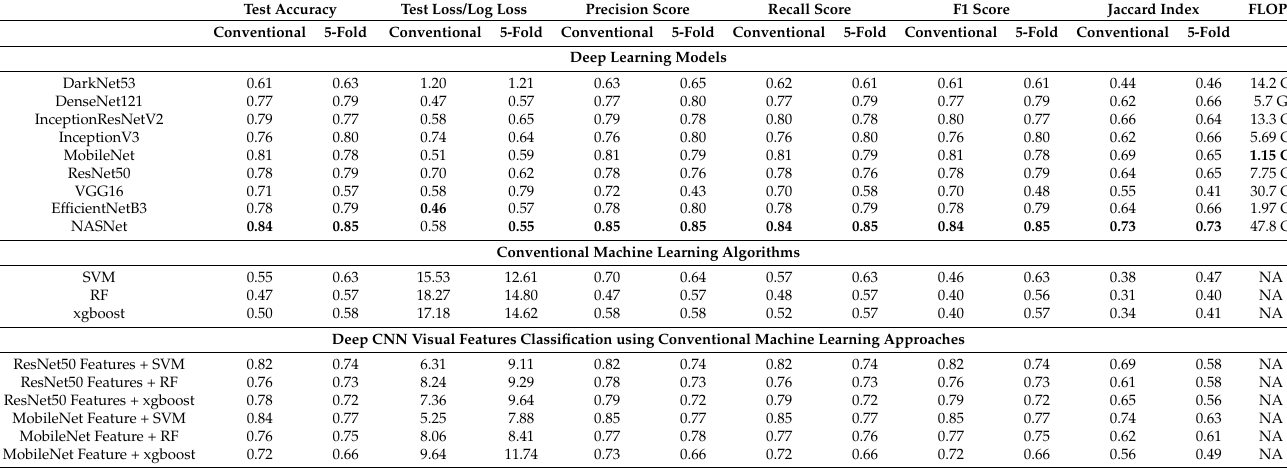
Table 1. Classification performance of implemented artificial intelligence models for visual blockage detection. TestAccuracy TestLoss/LogLoss PrecisionScore RecallScore F1Score JaccardIndex DeepLearningModels DarkNet53